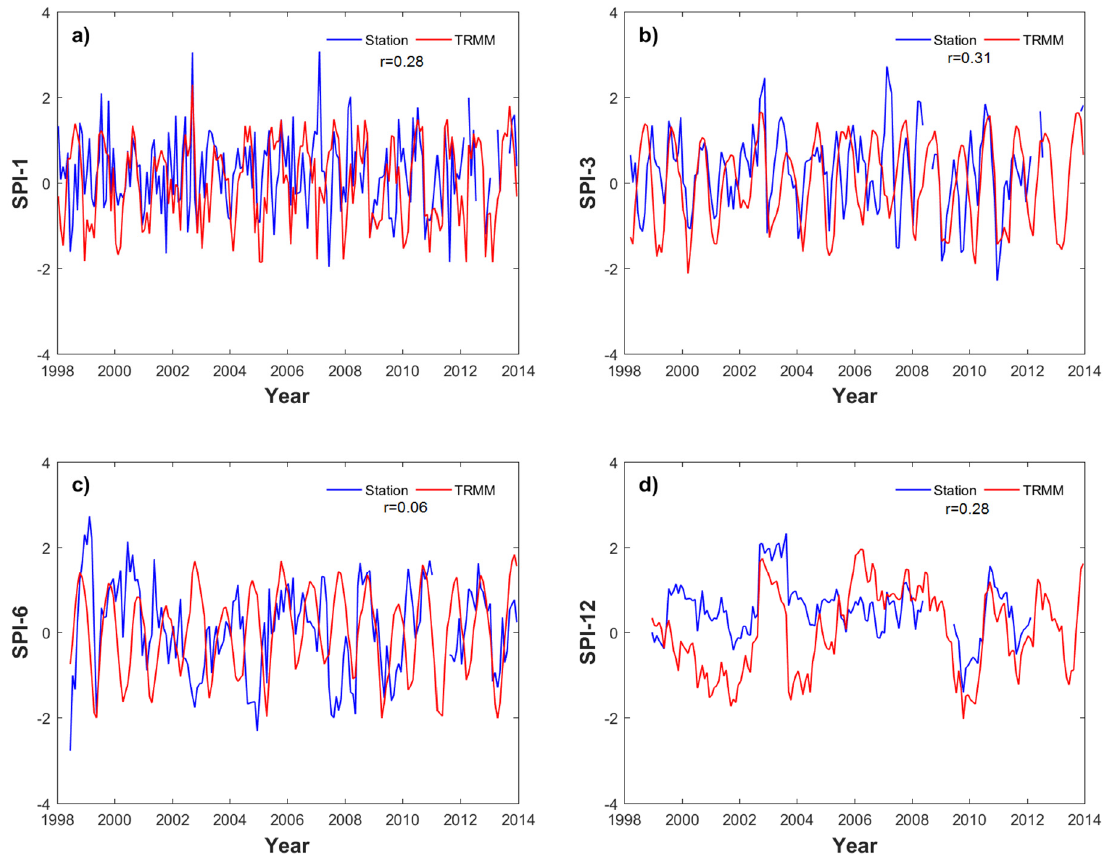
Figure 8. Comparison of SPI time series (TRMM-derived, blue line; Rain gauge derived, red line) at a humid climate (Yucatán state in the southeast of Mexico) for different timescales: one month ( a ); three months ( b ); six months ( c ); and twelve months ( d ). Pearson’s r correlation coefficient depicts the statistical agreement between both datasets.